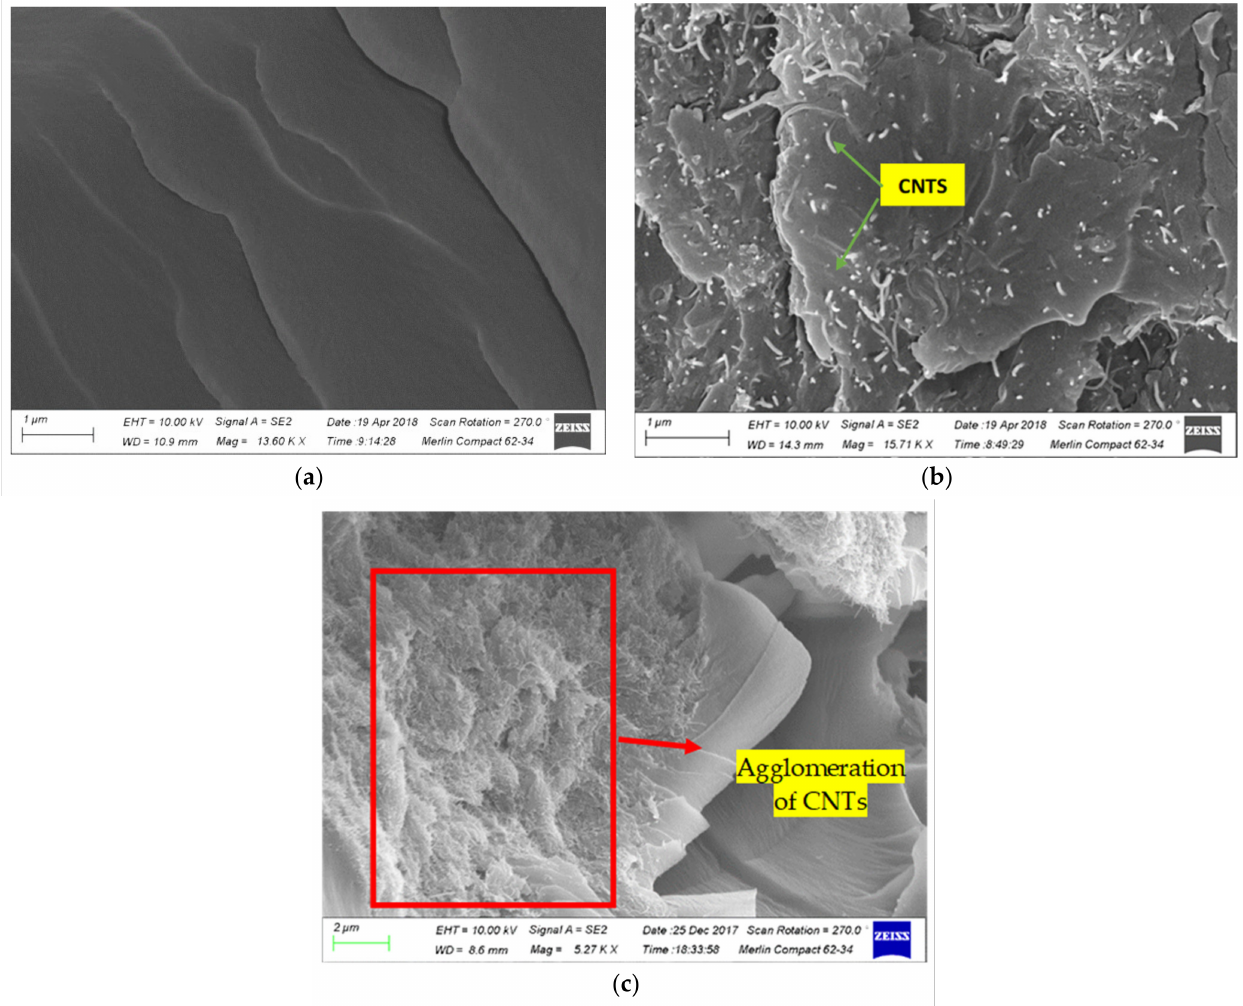
Figure 10. SEM images of epoxy/CNTs nanocomposites of ( a ) neat epoxy, ( b ) 1.5 wt.% of CNTs and ( c ) 2.0 wt.% of